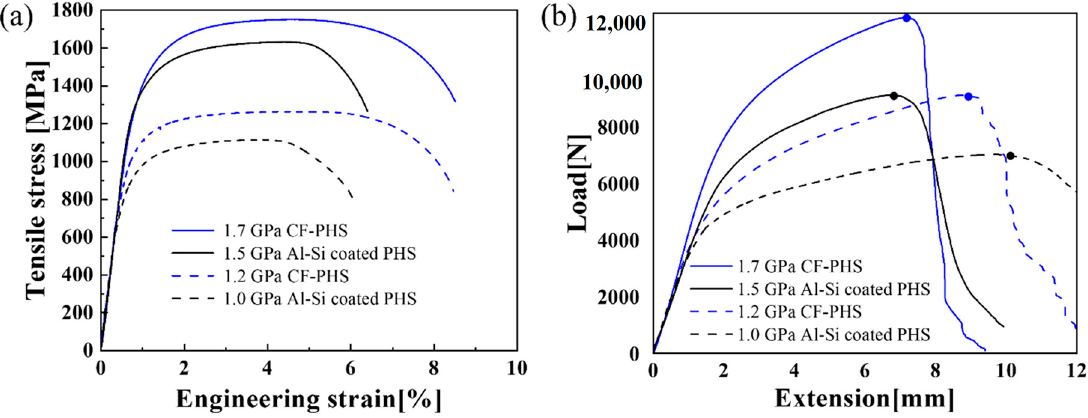
Figure 12. Tailor-welded blanks after hot forming of ( a ) bare PHS with 1.5 GPa/1.5 GPa and CF- PHSs with ( b ) 1.7 GPa/1.7 GPa and ( c ) 1.7 GPa/1.2